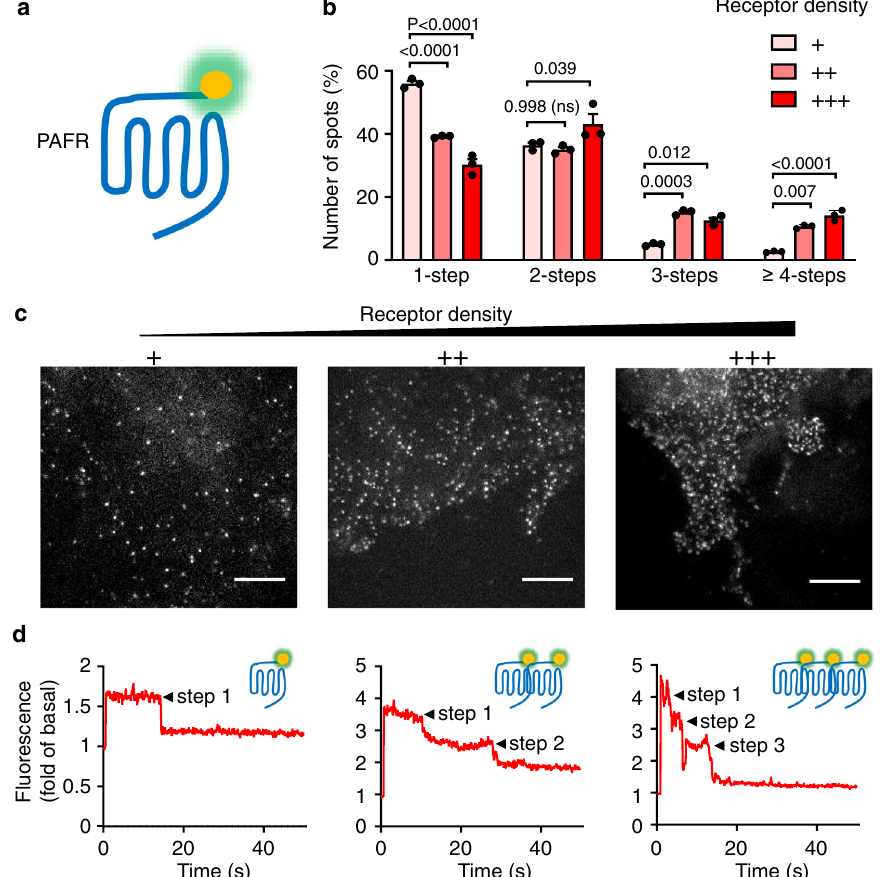
Fig. 1 | Single-molecule photobleaching analysis shows PAFR oligomer forma- tion on the cell surface. a Schematic representation of Halo-tagged PAFR labeled with the fl uorescent Halo-488 substrate. b Histogram of photobleaching step numbers for all Halo-PAFR molecules analyzed. Cells expressing three different densities of PAFR were used: +: 1994 spots from 21 movies, ++: 1956 spots from 15 movies,+++:1995spotsfrom17movies.Analyzedspotsarefrom5to7movieseach time and repeated three times. Data are mean±SEM from n =3 biologically inde- pendent experiments and were analyzed using one-way ANOVA with Dunnett ’ s multiple comparisons test. c Dependence of the distribution of monomers and dimers/oligomersonreceptor density. +:0.22±0.07particles/ μ m 2 ;++:0.42±0.07